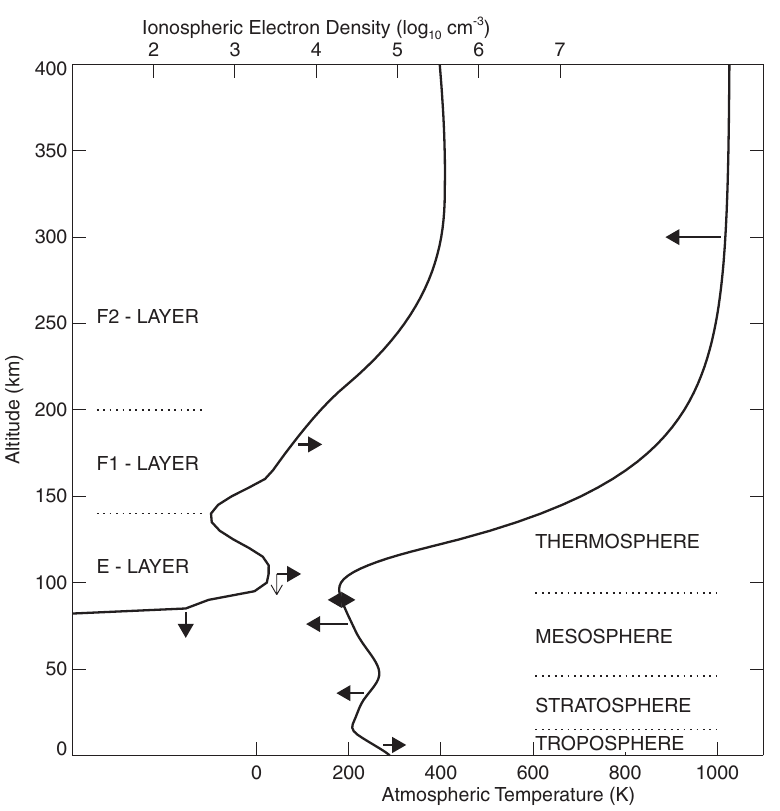
Fig. 1. Trends in the ionosphere and atmosphere. The ionospheric layers are defined by the electron density pro- file (midnight). The atmospheric layers are defined by the temperature profile. Arrows indicate the direction of long-term changes (Lasˇtovicˇka et al. ,